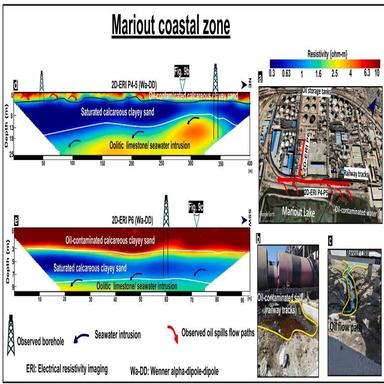
(a) 2D-ERI P4, P5 and P6 at Mariout Lake showing the oil-contaminated soil and oil leakage flow path towards Mariout Lake. (b and c) field photos showing oil-contaminated soil along railway tracks and oil storage tanks, respectively. (d and e) 2D electrical resistivity models of 2D-ERI P4-P5 and P6 obtained from 2D inversion of jointed Wa and DD (Wa-DD) datasets, respectively, applying AIA using a blocky model option (L1-norm inversion) and calibrated with the observed borehole information and RS data.